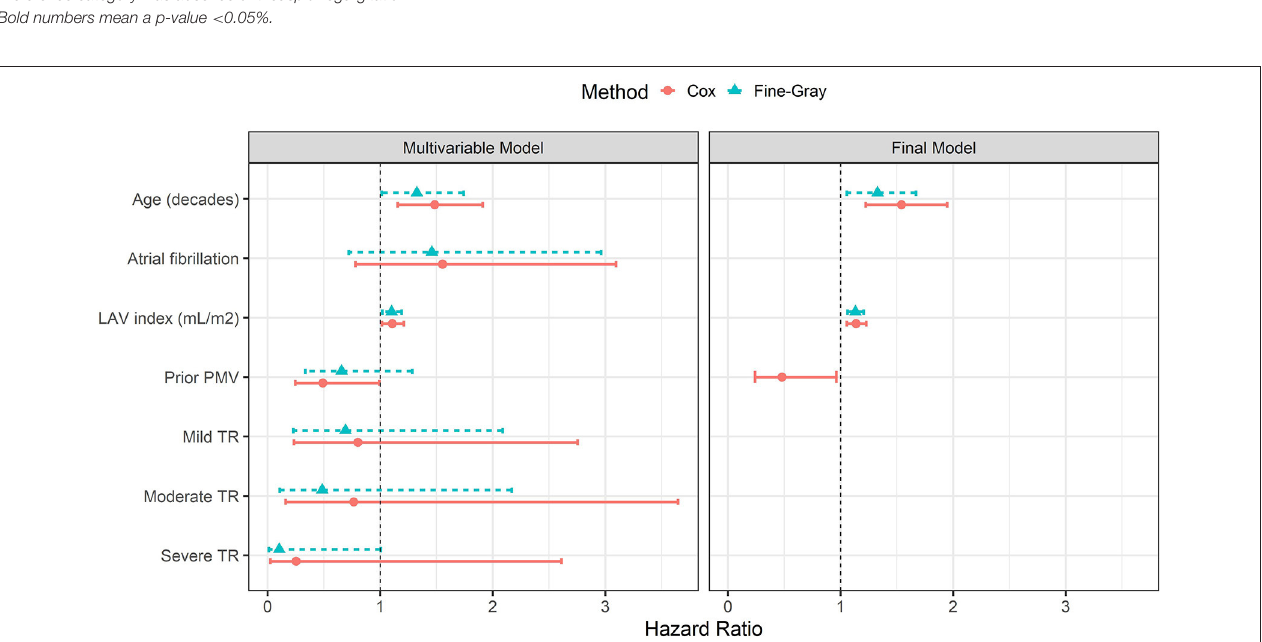
FIGURE 3 | Multivariable predictive models for prediction of mitral regurgitation (MR) progression in patients with rheumatic heart disease (RHD). Cox proportional hazards model considering mitral regurgitation (MR) progression as the primary event and the Fine-Gray model analyzing death and mitral valve replacement as a competing